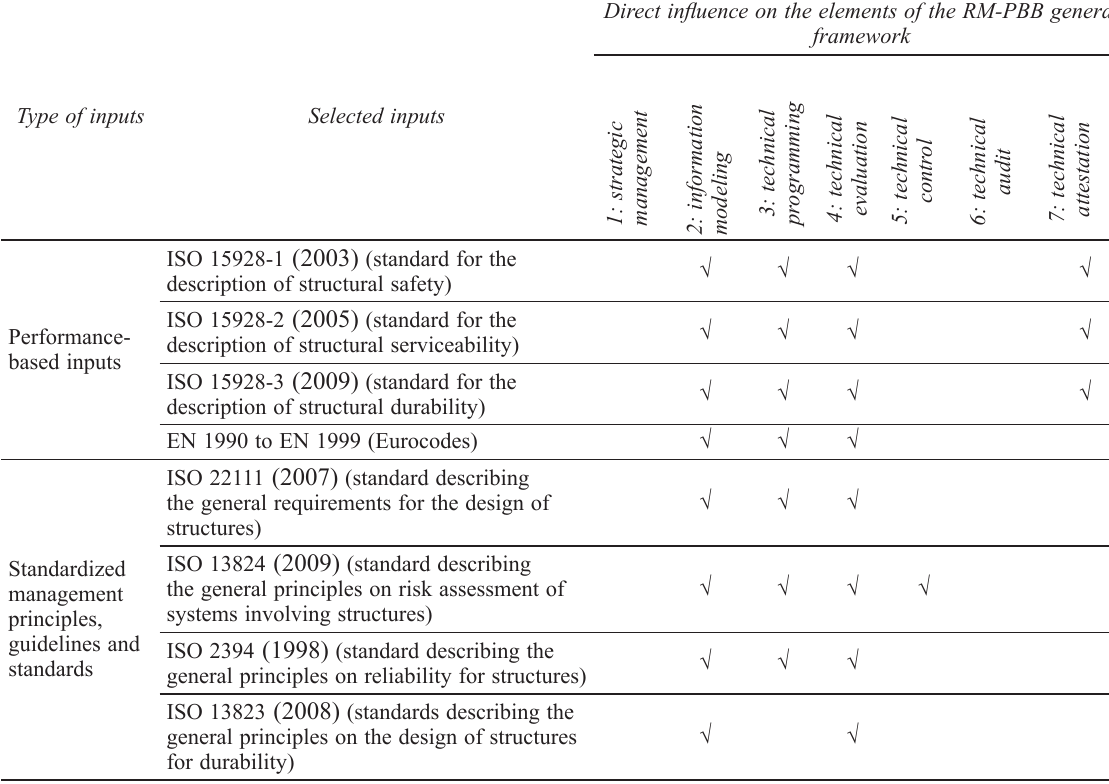
Table 1. Inputs for adapting the framework to the context of building structures